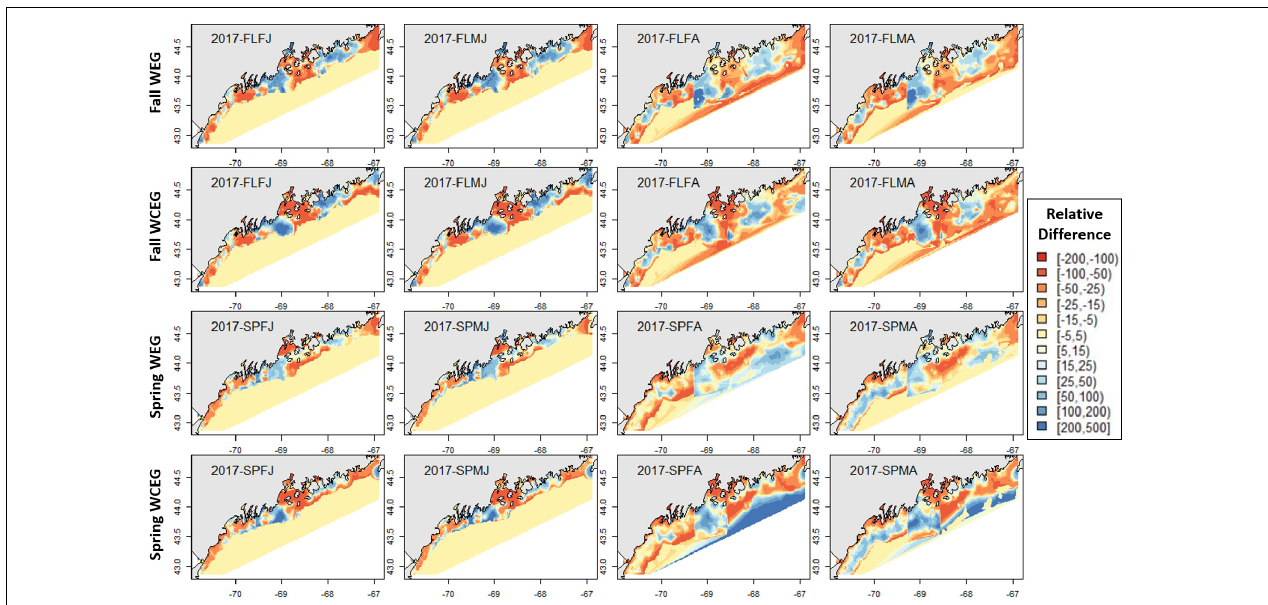
FIGURE 8 | 2017 American lobster relative differences in model abundance estimates. Legend numbers represent relative differences (%) between either the West-East1-GAM (WEG) or the West-Central-East2-GAM (WCEG) approach and the GOM–GAM. Red legend colors indicate areas where the GOM–GAM is predicting higher lobster abundance than the model in comparison. Blue legend colors indicate areas where the GOM–GAM is predicting lower lobster abundance then the localized model approach in comparison. Pale yellow colors indicate similar abundance estimates between the GOM–GAM and localized models. Each column represents a lobster season × sex × size group. Each row represents the season and localized model approach compared to the corresponding GOM–GAM.